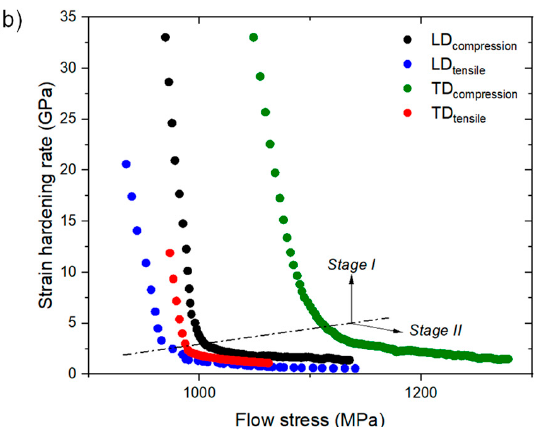
Figure 4. ( a ) True stress vs. true strain representation and ( b ) strain-hardening rate vs. flow stress for the tensile and compression tests performed in two different orthogonal directions (LD and TD).